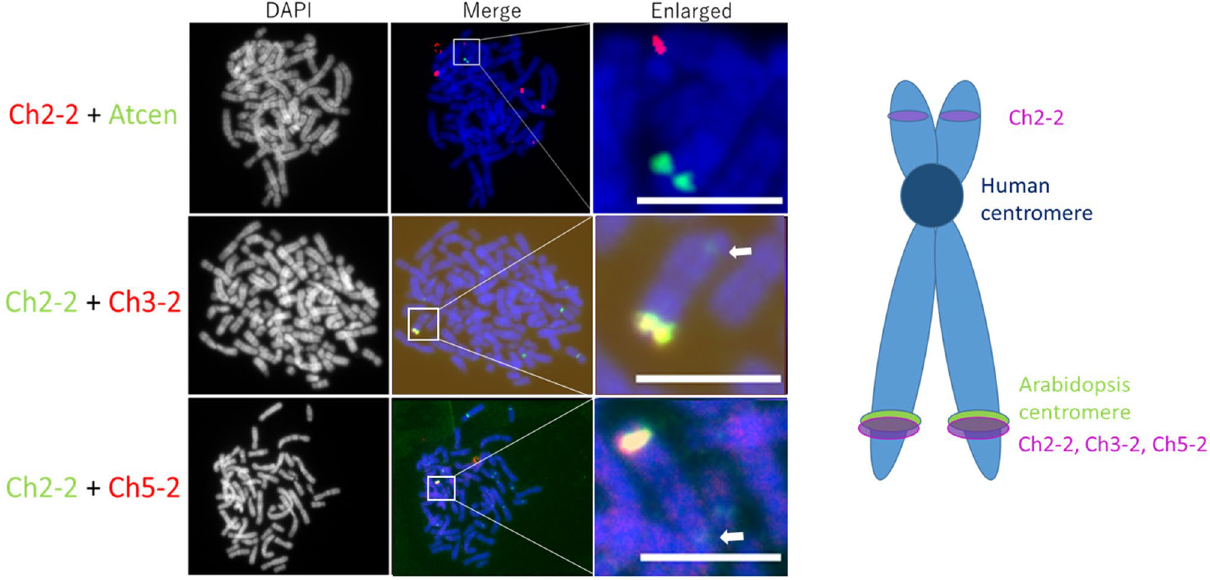
Figure 6. Simultaneous localization of Arabidopsis probes Ch2-2, Ch3-2, Ch5-2 and Arabidopsis centromere (Atcen) probe by FISH on metaphase chromosomes in the hybrid cell line. Arrows indicate weak Ch2-2 signals on the short chromosome arm. Scale bars, 5